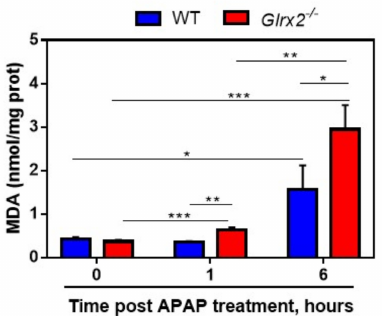
Figure 6. Glrx2 knockout increased malondialdehyde (MDA) levels in APAP-treated livers. MDA level in livers from the mice exposed to 300 mg · kg − 1 APAP was detected. Statistical difference among groups was analyzed by two-way ANOVA. Data are shown as mean ± SEM, n = 4, * p < 0.05; ** p < 0.01; *** p <